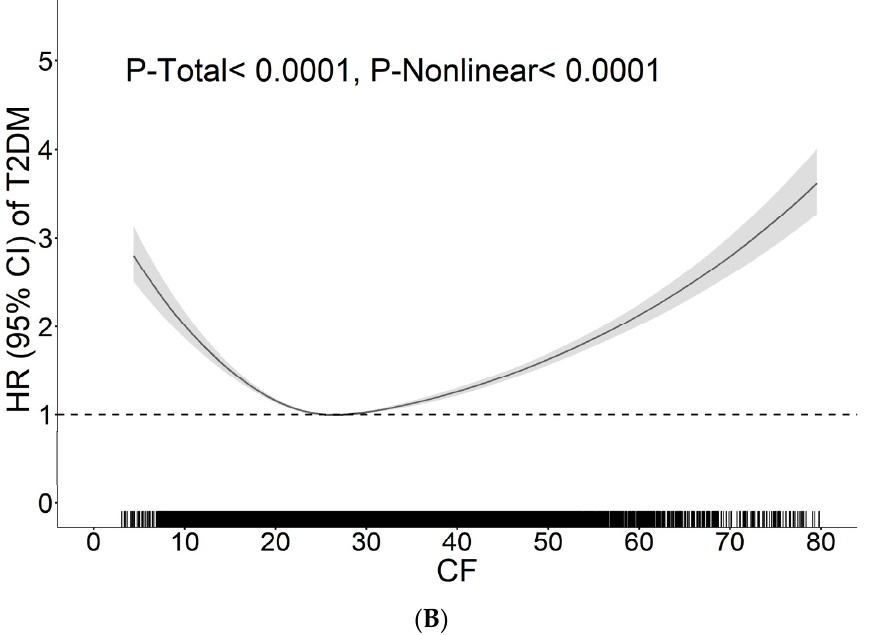
Figure 1. The dose–response relationship between dietary GI and CF values and T2DM risk in 14,590 Chinese adults of the China Health and Nutrition Survey 1997–2015 1 . 1 The potential for nonlinearity and dose–response relationship of the associations between dietary GI and CF values and the risk of T2DM was explored using restricted cubic spline with four knots (5th, 35th, 65th, 95th). Black solid lines were adjusted HRs of T2DM risks associated with dietary GI ( A ) or CF ( B ) values. Gray shade areas showed corresponding 95% CIs. Dotted lines indicated reference lines for no association (HRs of T2DM risk were 1) where dietary GI was 70.0 and dietary CF was 25.4. The rugs showed fraction of participants with different dietary GI ranging of 40–85 and CF ranging of 0–80, respectively. The HR of T2DM risk associated with dietary CF value was adjusted for age, sex, education level, urbanization index, region, smoking status, alcohol consumption, BMI, physical activity status, total energy, cholesterol and PUFA to SFA ratio and the HR of T2DM risk associated with dietary GI value was additionally adjusted for total carbohydrate and fiber intakes. Abbreviations: